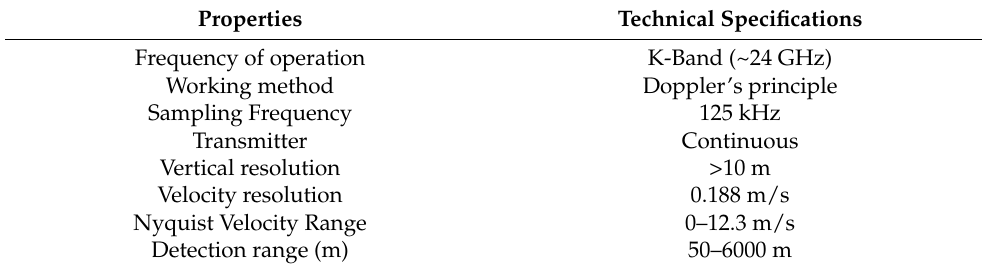
Table 2. The micro rain radar (MRR2)